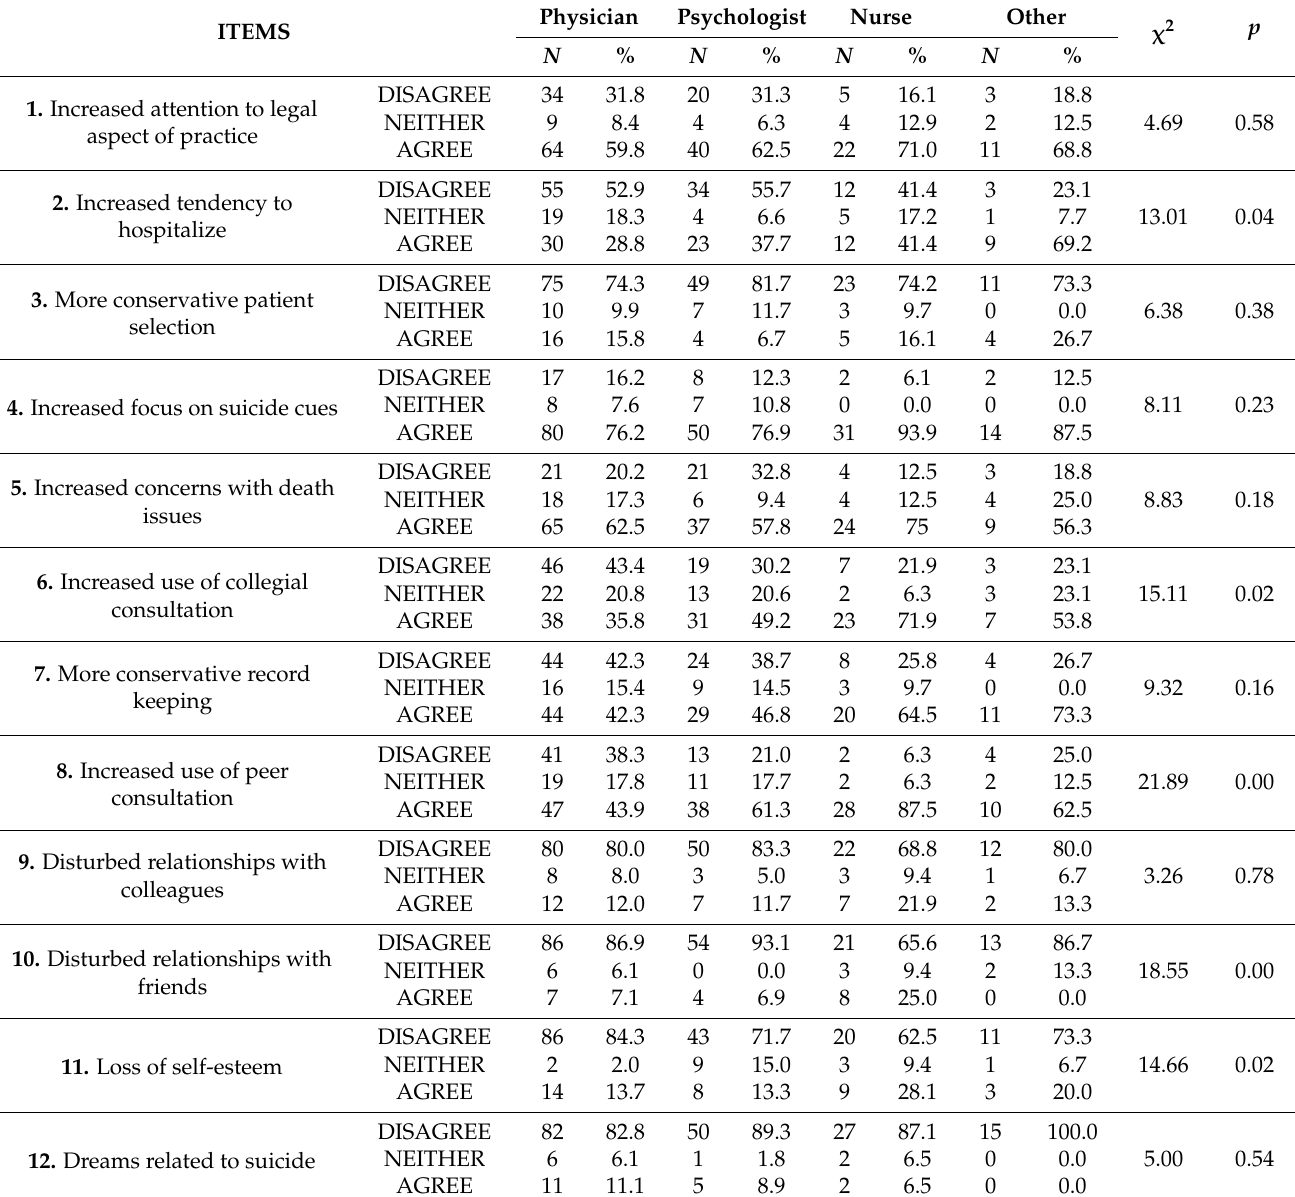
Table 4. Impact of a patient suicide on the professional and personal lives of healthcare